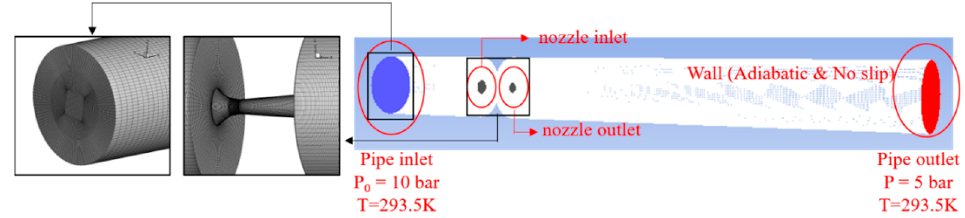
Figure 8. Three-dimensional geometry of pipe with critical nozzle.